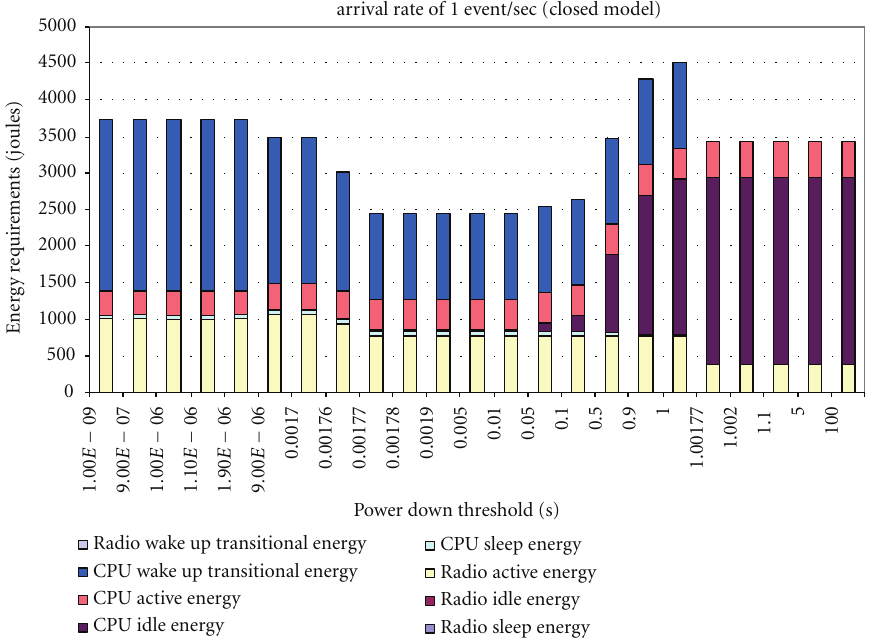
Figure 15: Power down threshold versus energy requirement for a closed model with a job arrival rate of 1 event/second.